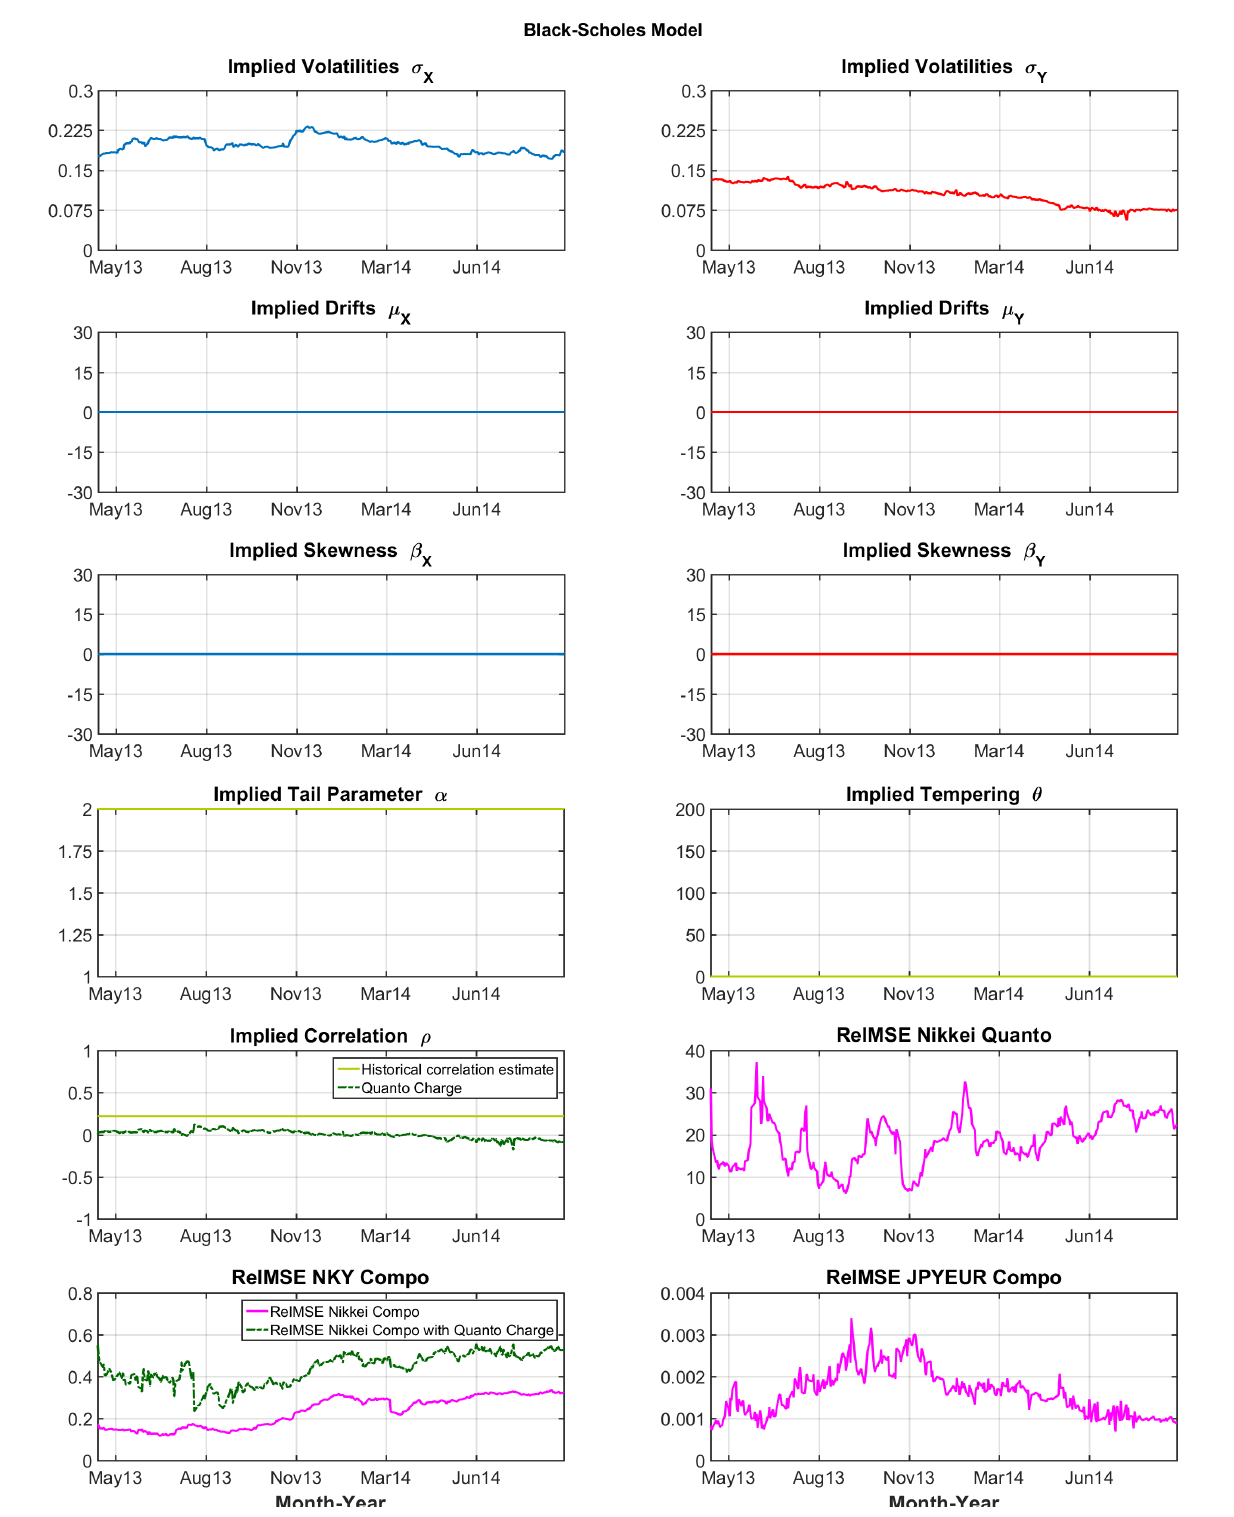
Figure 9. Quanto and compo options: daily calibrated Black–Scholes parameters and RelMSEs. Sample period 16 April 2013 to 15 September